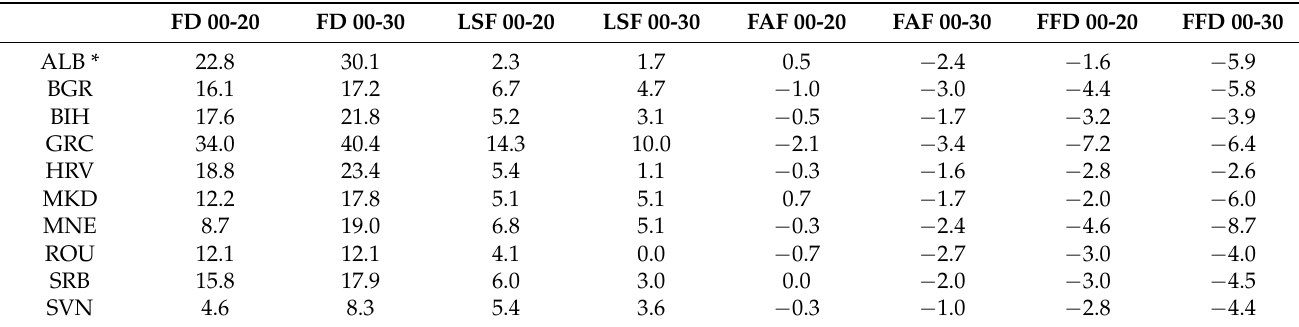
Table 2. The percentage (%) difference between the reference period 2000 (00) median and the two- time horizons 2020 (20) and 2030 (30) medians for all the frost indicators (FD, LSF, FAF and FFD), per